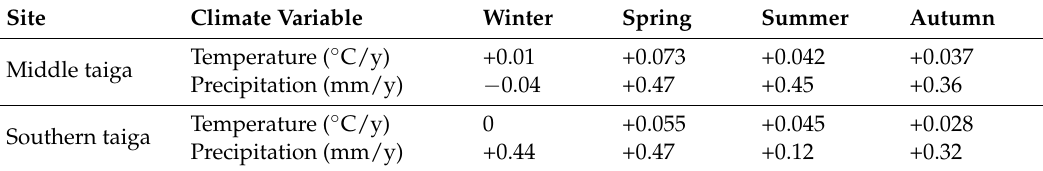
Table 6. Observed warming ( ◦ C/year) and precipitation (mm/year) trends by location and season during 1990–2014. Concurrently with small increases in precipitation in southern taiga, snow water content has been decreasing at the rate of 0.82 mm/year in recent years, compared to the 1971–2000 average